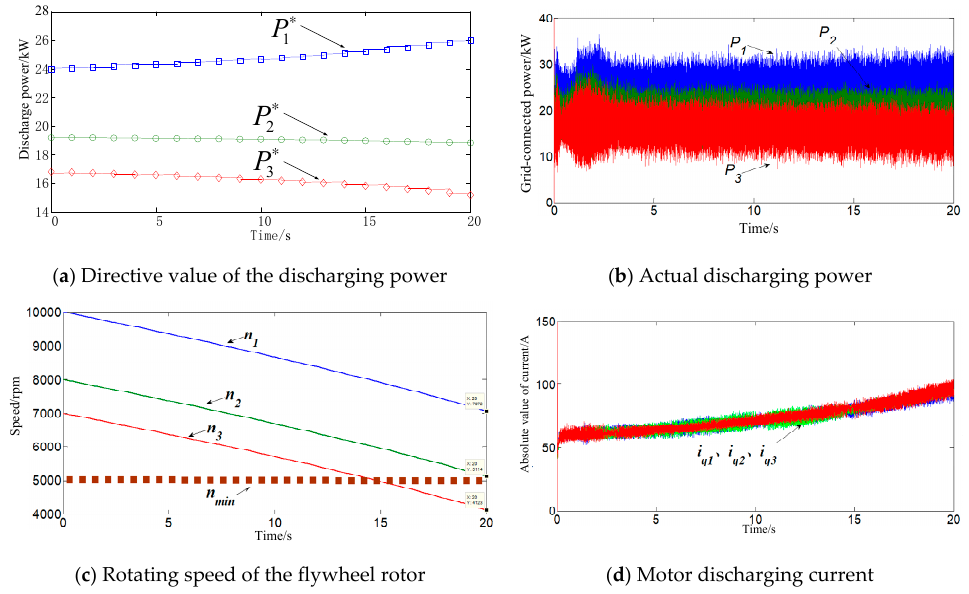
Figure 20. Simulation waveforms of discharging power distributed by the rotating speed.